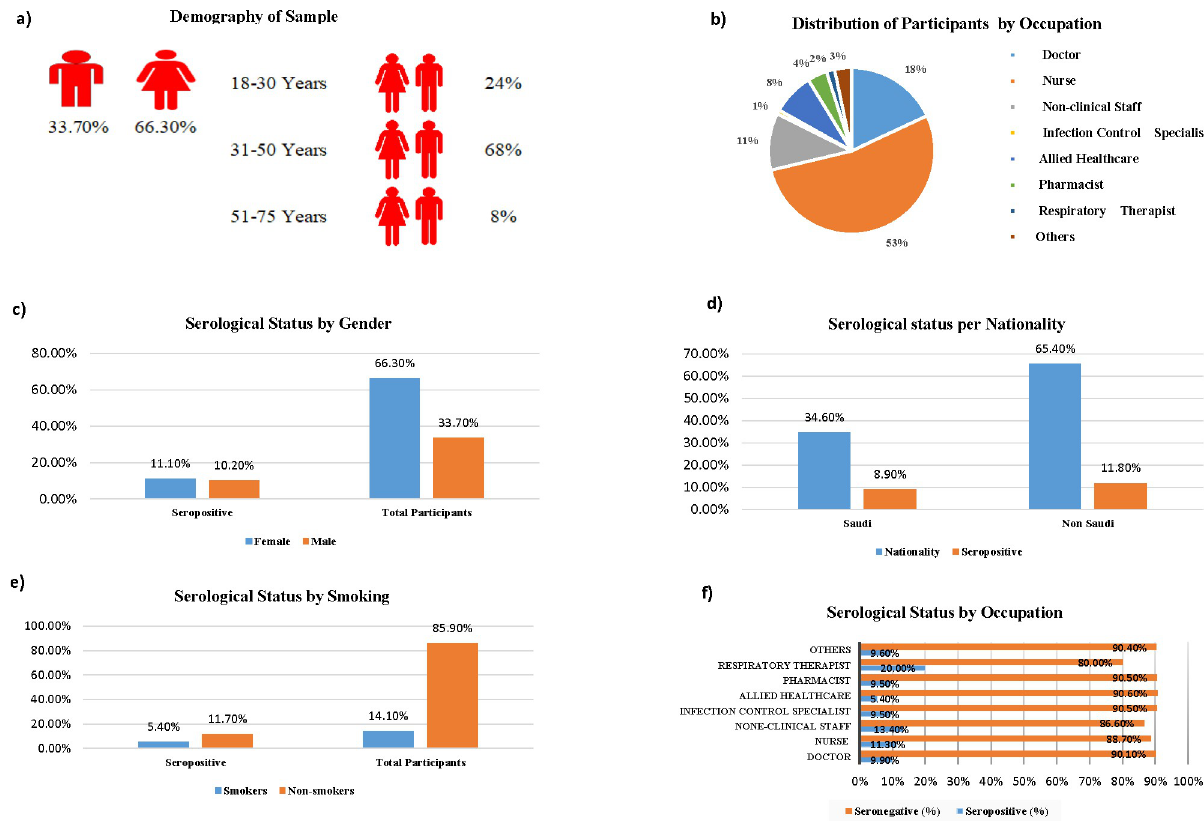
Fig 1. Sociodemographic and clinical characteristics of the study population. (A) Demography of sample. (B) Distribution of Participants by Occupation. (C) Serological Status by Gender. (D) Serological status per Nationality. E) Serological Status by Smoking. (F) Serological Status by